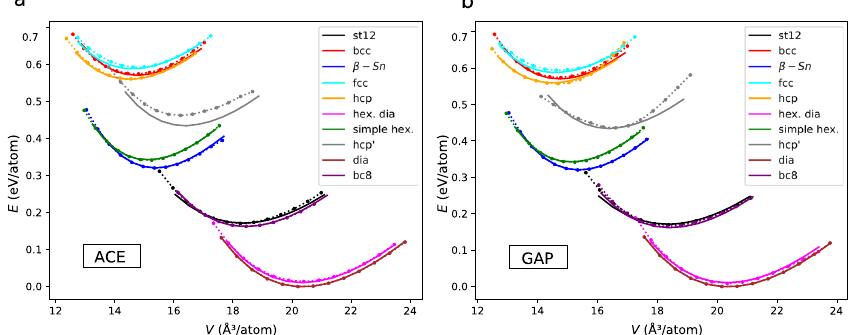
Fig. 6 Energy vs. volume for Si. Shown are bulk crystal lattices compared to DFT reference (solid). Both models were not explicitly fi tted to the hcp ’ structure, requiring the ACE ( a ) and GAP ( b ) to